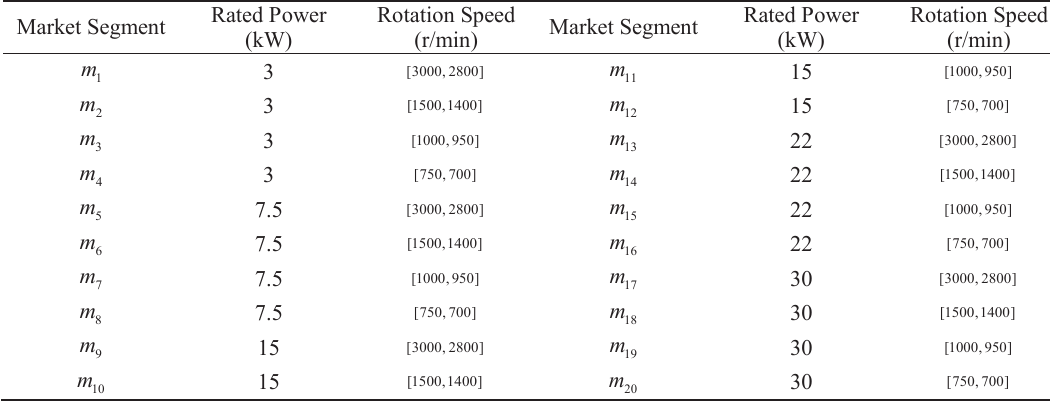
Table 3. Market segments of three-phase asynchronous motor